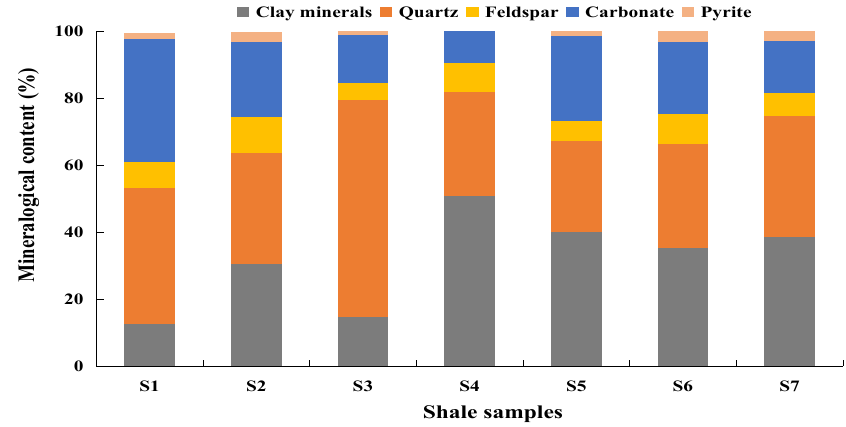
Figure 4. Mineralogical compositions of shale samples.